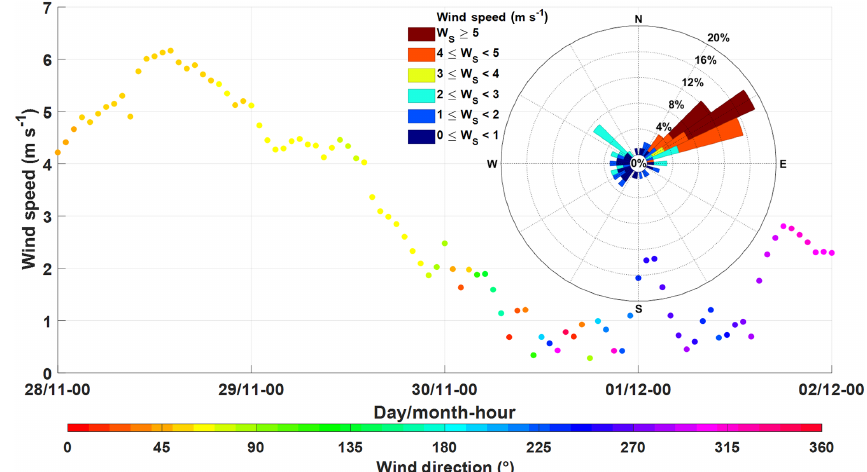
Figure 4. Wind rose and temporal evolution of wind intensity and direction at 10m from ERA5 during 4d of the 2016 APE. The coloured scale for wind speed (Ws) refers to the wind rose.